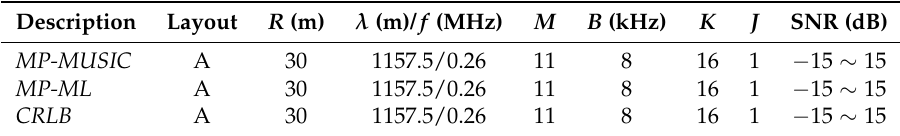
Table 3. Parameter setting in insufficient snapshot scenarios.